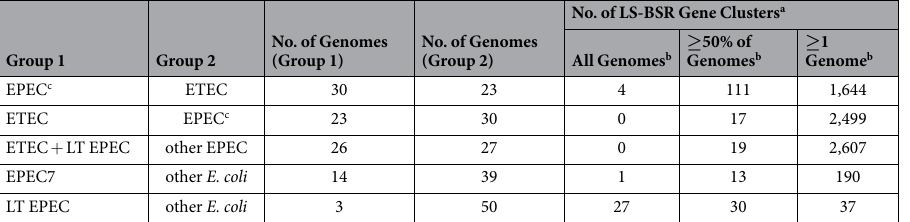
Table 2. LS-BSR analysis of the EPEC and ETEC isolates analyzed in this study a The total number of core gene clusters (LS-BSR value ≥ 0.8) in all of the genomes (n = 53) analyzed was 1,617. b The number of gene clusters that were present in all genomes, ≥ 50% of the genomes, or ≥ 1 of the genomes of Group 1 (LS-BSR ≥ 0.8) and absent from all of the genomes of Group 2 (LS-BSR < 0.4). c The EPEC/ETEC isolates were included in the EPEC group due to their similarity to EPEC in the phylogenomic